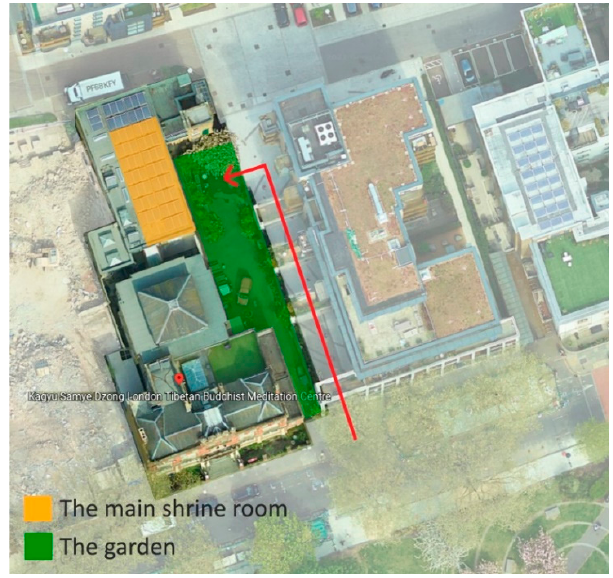
Figure 4. Plan of Kagyu Samye Dzong London (Diagram by primary author).